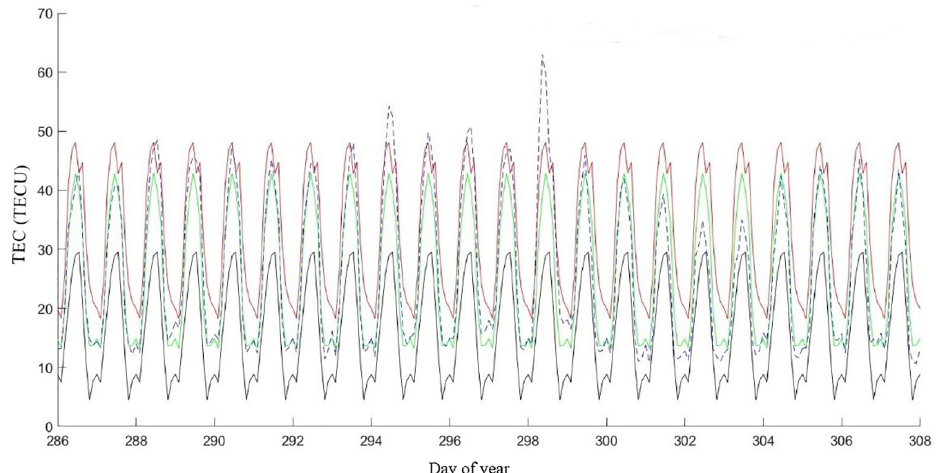
Figure 8. GIM-TEC values for BING Station. The black line shows lower bound TEC values, the red line demonstrates upper bound TEC values, the green line shows mean TEC values and the dotted line indicates observed TEC values for every